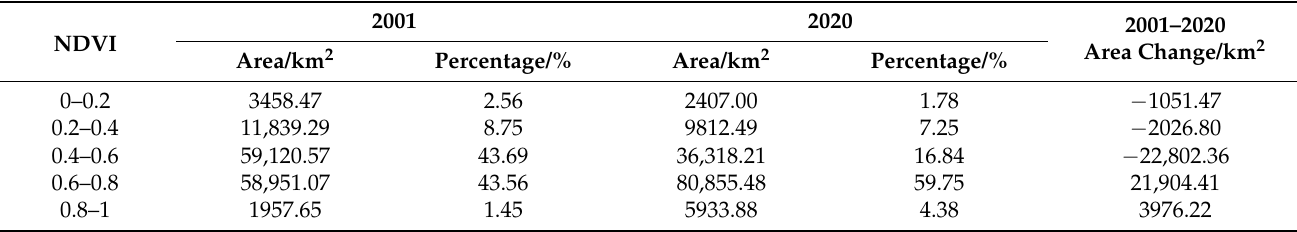
Table 1. Changes in area and proportion of NDVI at all levels from 2001 to